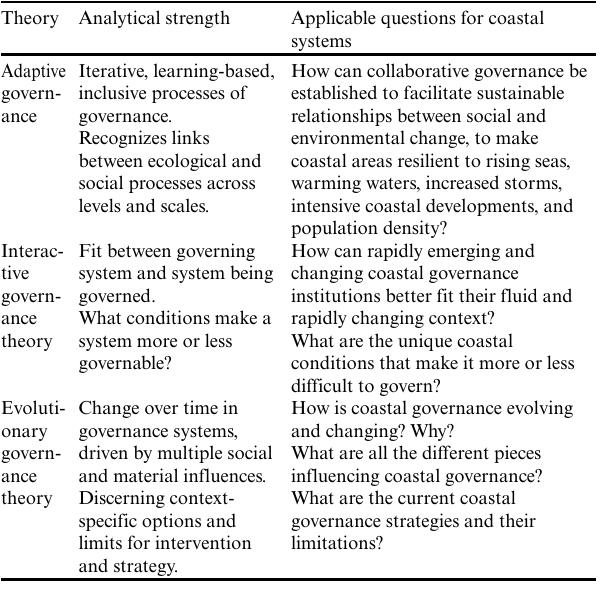
Table 3 . Combinatory theories and theoretical frameworks. Their brief analytical strength and when they could be applied to coastal systems and